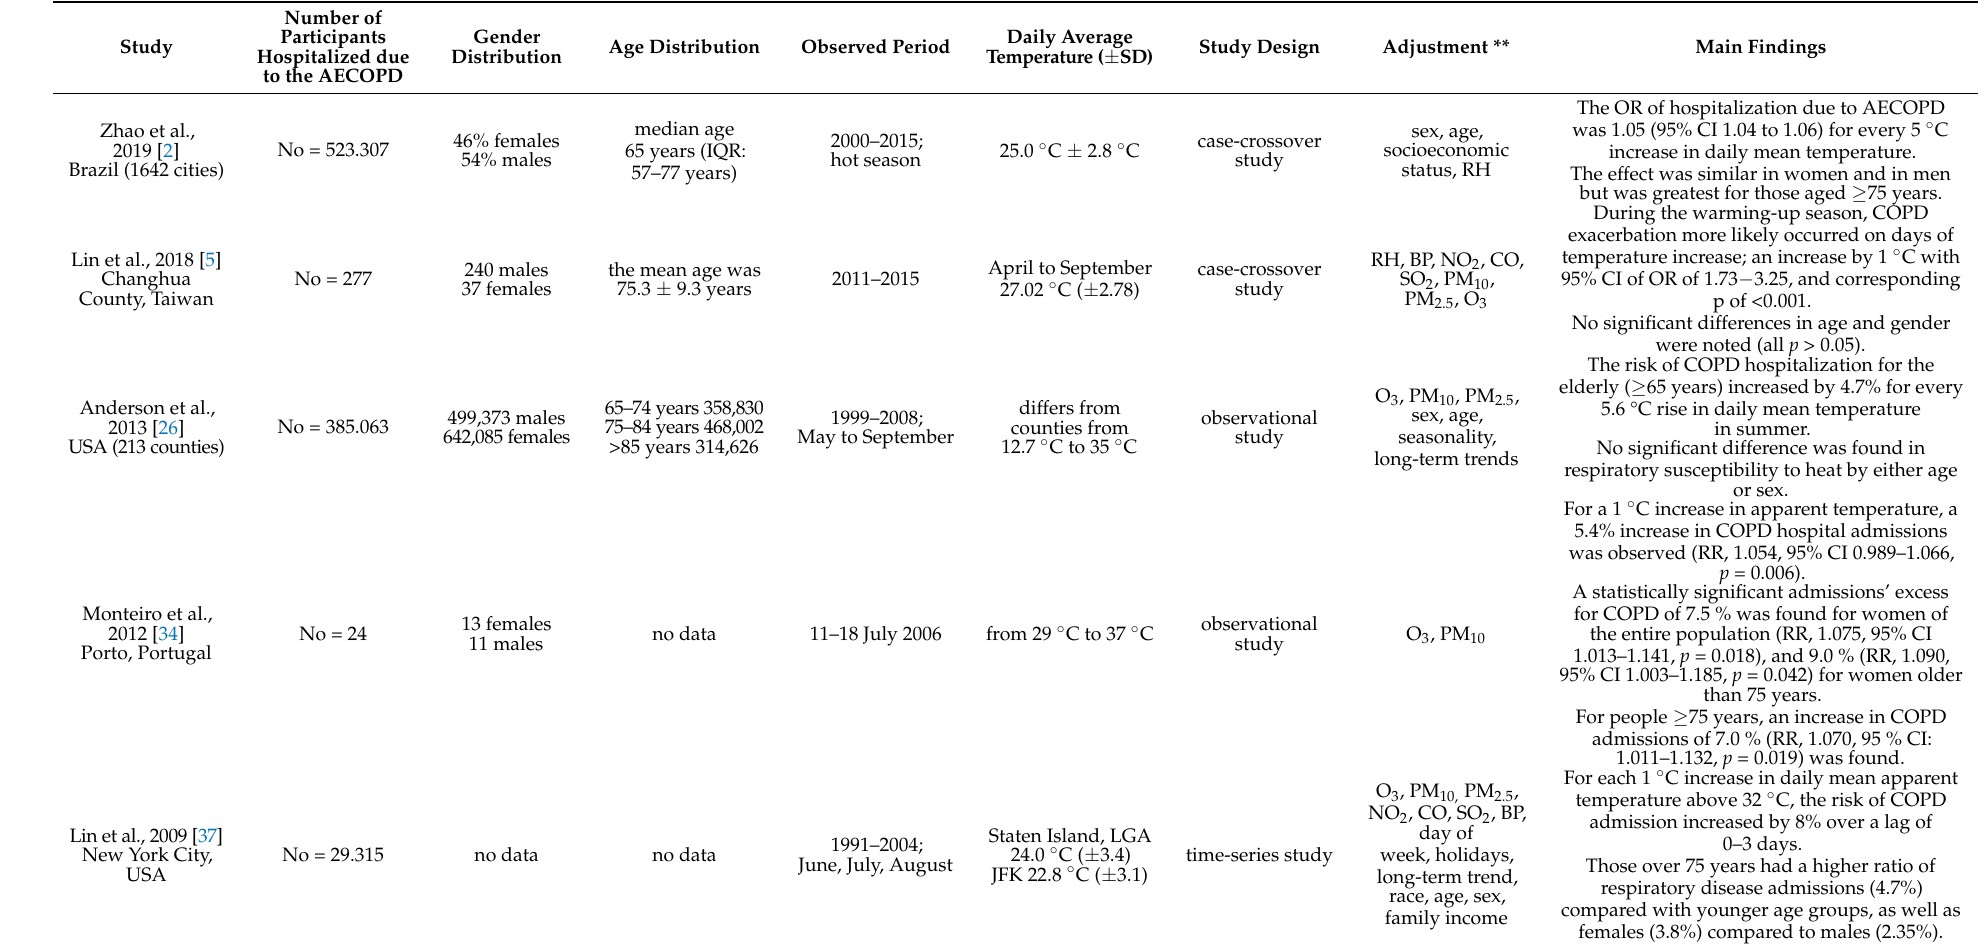
Table 2. The effects of increased air temperatures on AECOPD hospitalizations/outpatients’